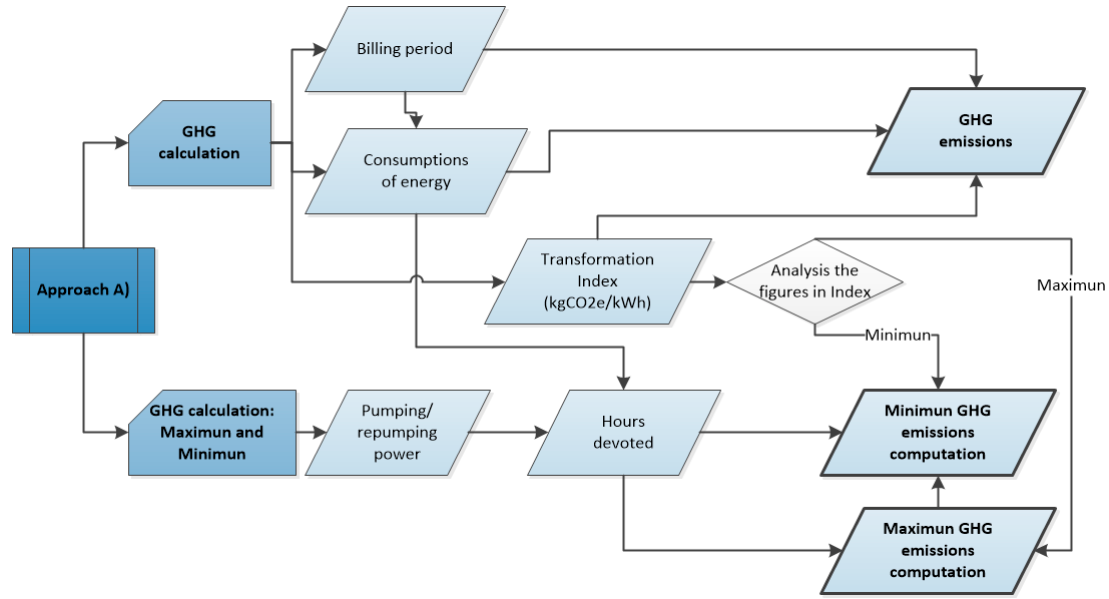
Figure 1. Approach A. This is based on the characterization of pumping stations in the studied WUAs, its transformation in energy and the subsequent GHG emissions.